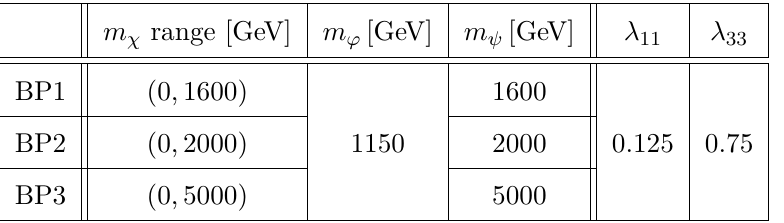
Table 2 . Benchmark points for dark matter in models with color-sextet mediators consistent with LHC and FCNC constraints. The sextet-DM Yukawa coupling y χ is permitted to vary in all benchmarks.